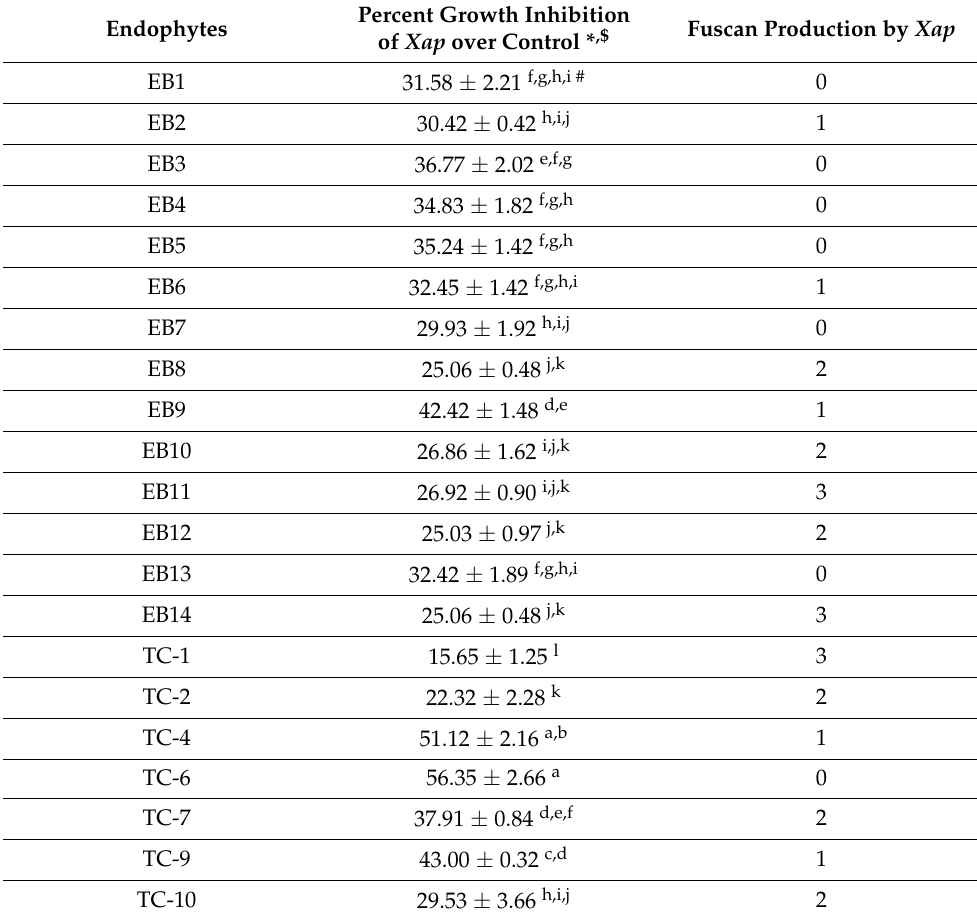
Table 2. Effect of the bacterial endophytes on growth of X. axonopodis pv. punicae in dual culture and fuscan production by X. axonopodis pv. punicae ( Xap